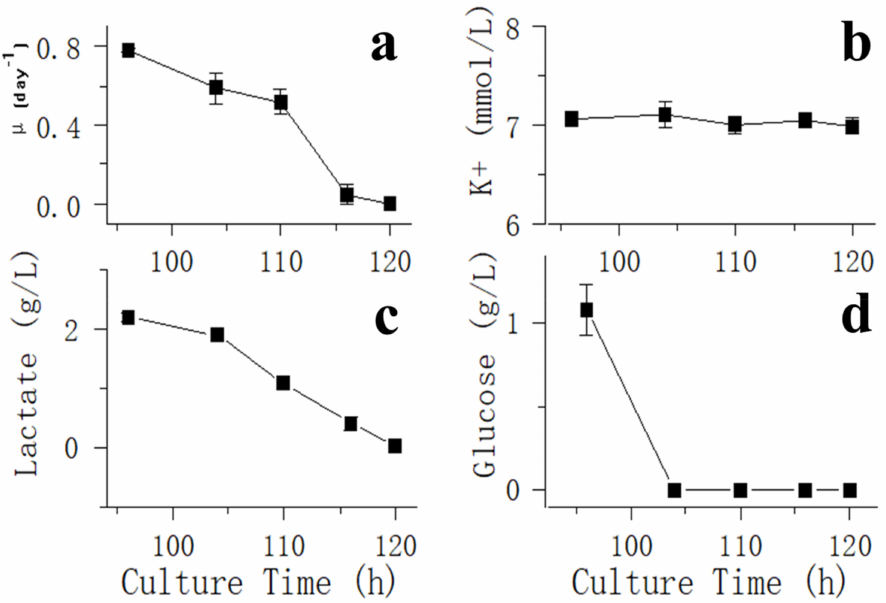
Figure 2. Impact of glucose withdrawal on cell culture performance and metabolite profiles in the exponential phase. Data are expressed as mean ± standard error of three replicates. ( a ) VCD,